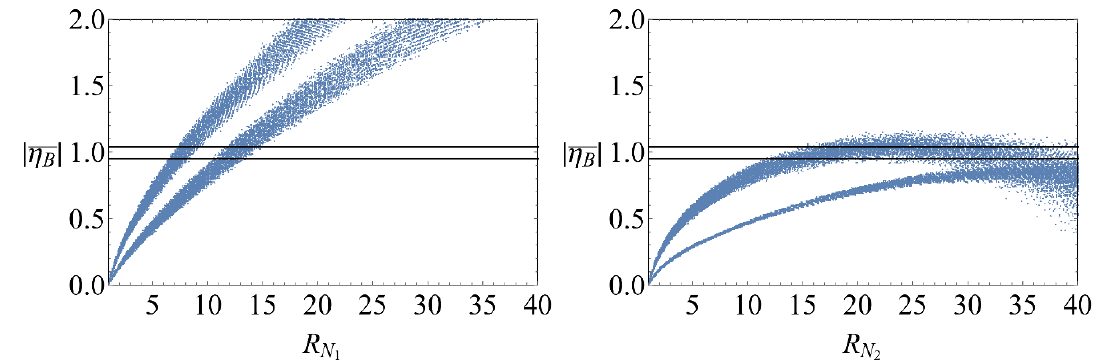
Figure 12 . Normalised baryon to photon ratio with the R parameters which quantify a particular N i